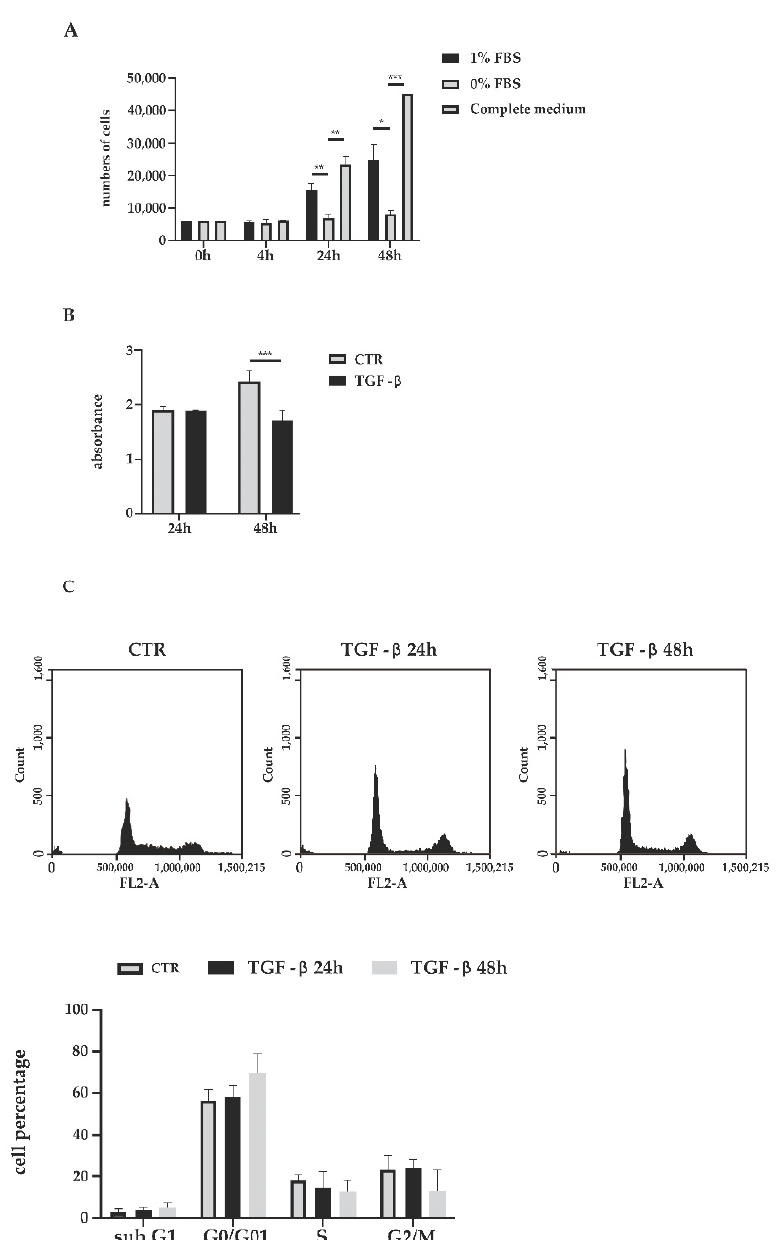
Figure 1. ( A ) Viability of human cholangiocytes exposed to different concentrations of FBS. ( B ) Cytotoxic effect of TGF- β at the dose of 10 ng/mL for 24 h and 48 h. ( C ) Cell cycle analysis by flow cytometry of cholangiocytes cultured in medium with 1% FBS or treated with TGF- β at the dose of 10 ng/mL for 24 h and 48 h. The relative percentage of cells in different cell phases is reported for each time step. Statistical analysis performed with the Kruskal–Wallis test did not show significant differences ( p < 0.05). * p ≤ 0.05, ** p ≤ 0.01, and *** p ≤ 0.001.